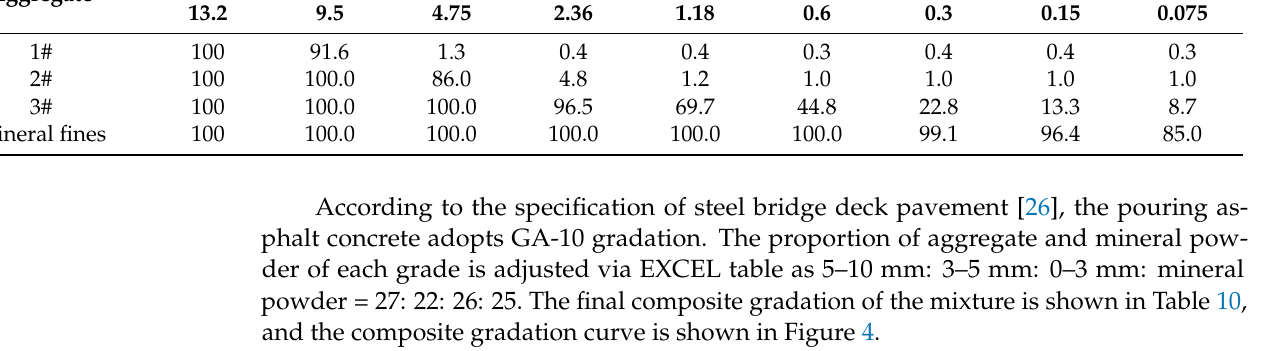
Table 9. Screening results of various aggregates and powders.